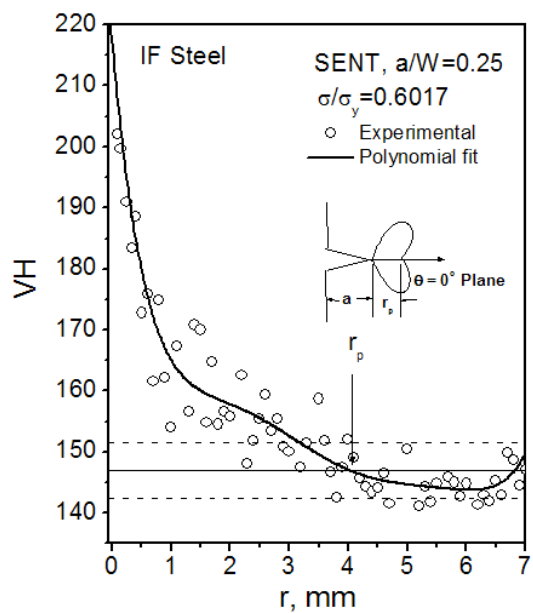
values ahead of a